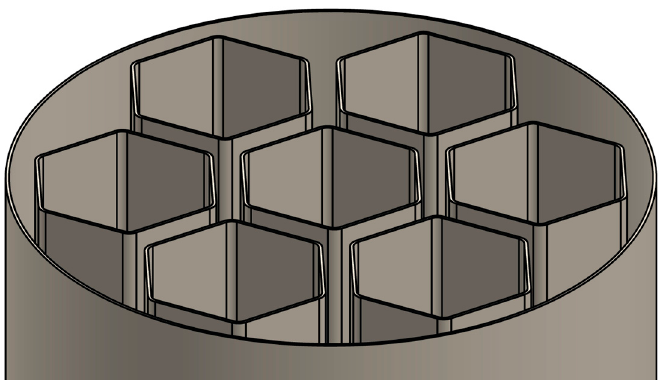
Figure 1. Sketch of the basket with hexagonal fuel assembly cells holding spent nuclear fuel. The basket of CASTOR ® 1000/19-type cask consists of 19 hexagonal cells [16], with the length of the hexagon side of 150 mm and the total length of 4630 mm.